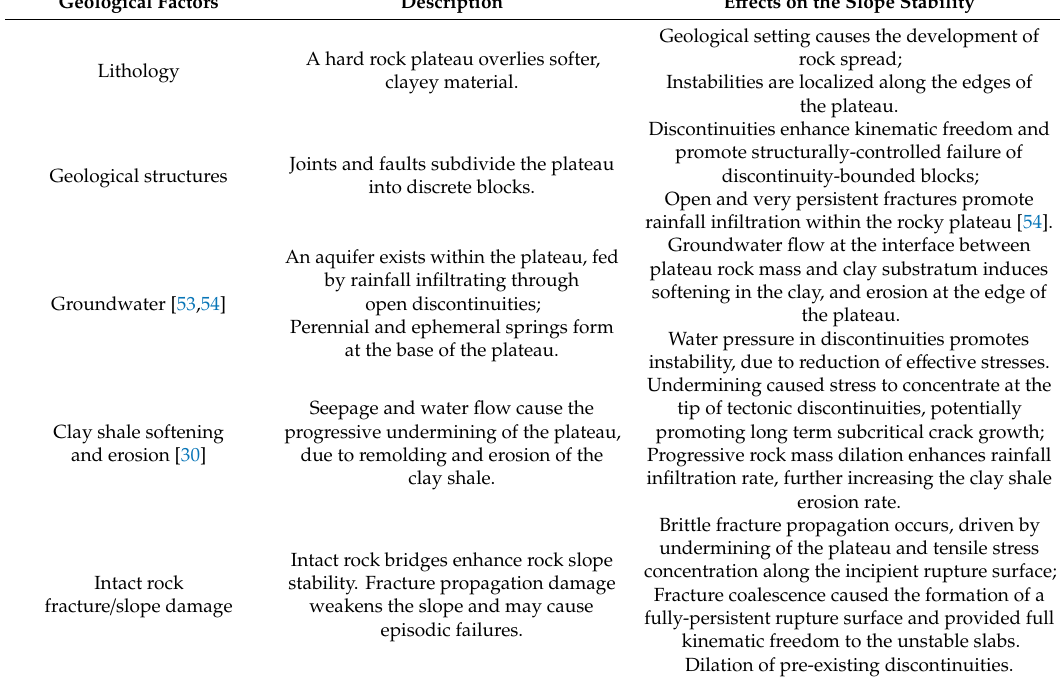
Table 6. Summary of the potential factors controlling the stability of the slopes at San